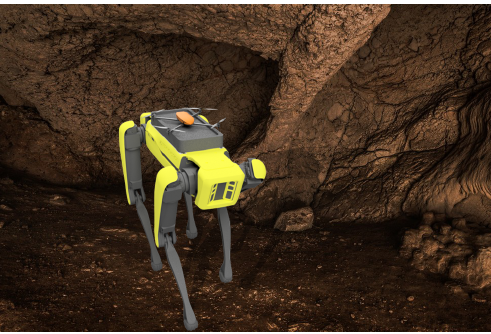
Figure 1. Concept of the unified legged-aerial robotic platform for lava tube exploration.